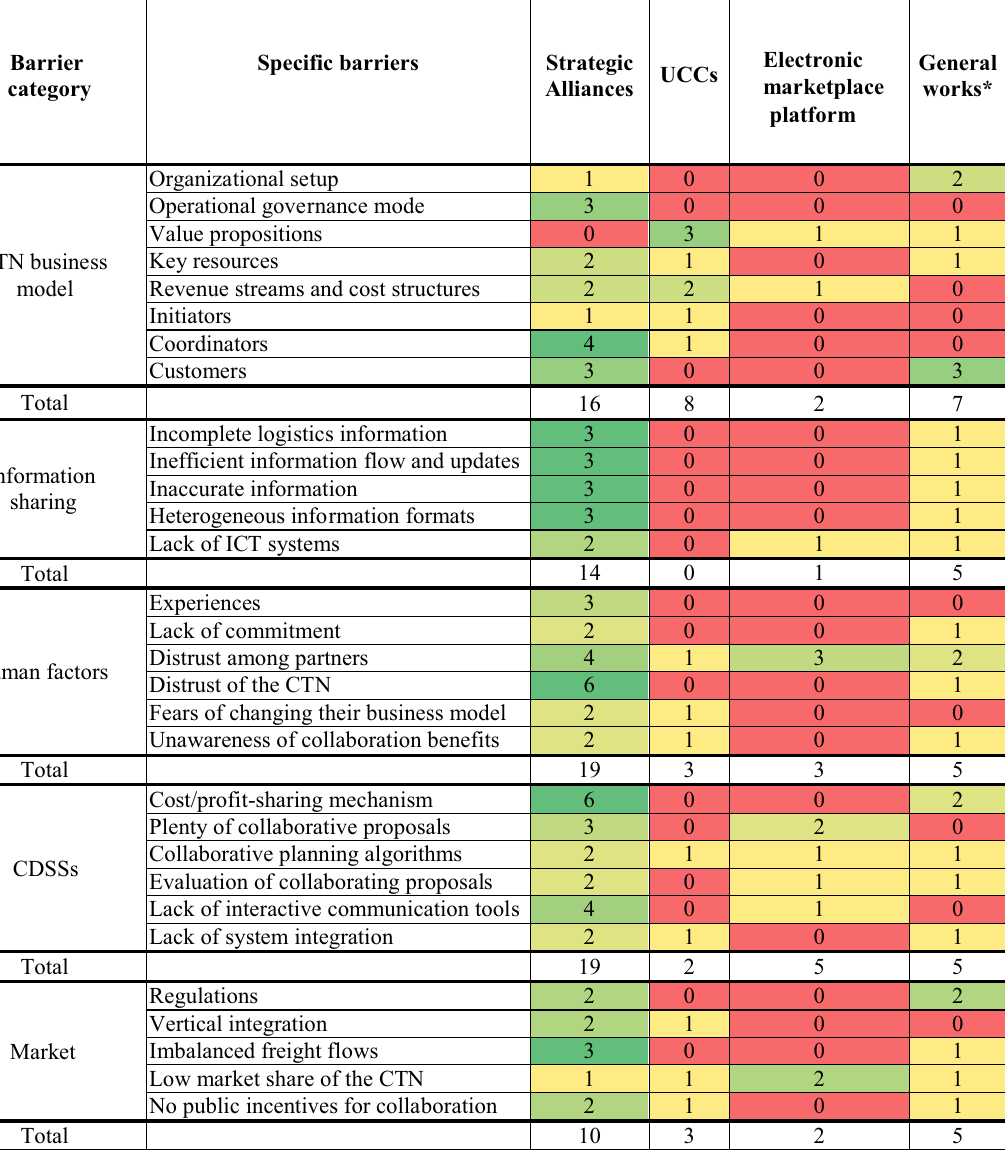
Specific barriers